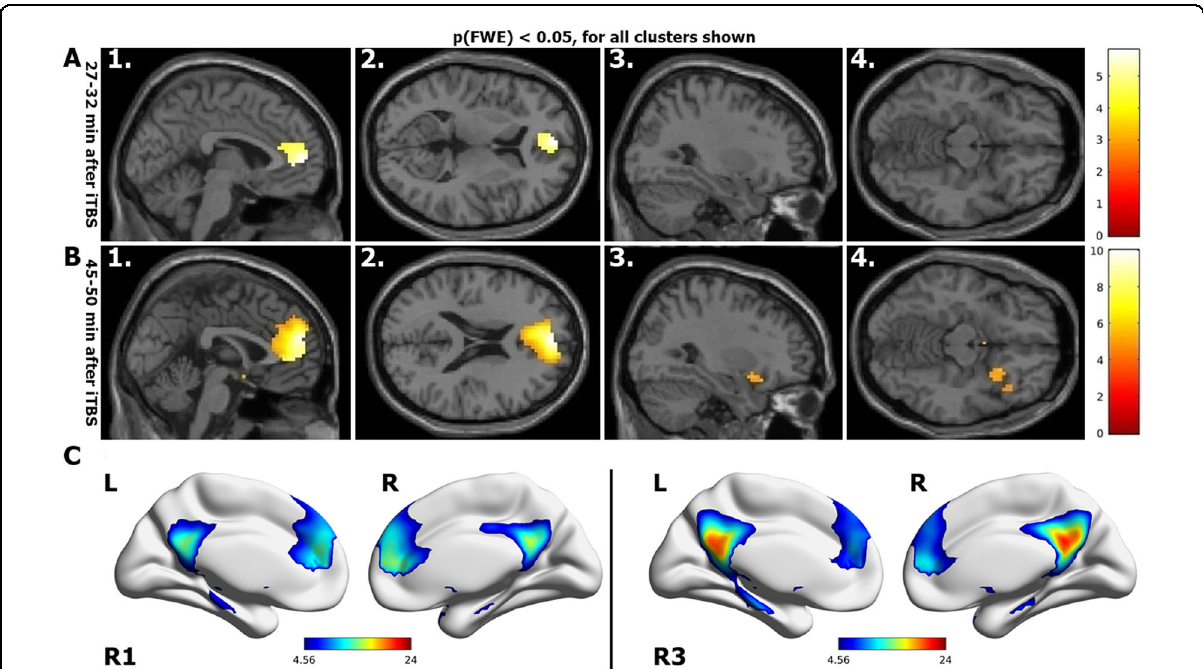
Fig. 3 Functional connectivity results. Regions that show reduced functional connectivity to DMN after stimulation (real-sham condition, whole- brain corrected p FWE < 0.05): ( a 1-2) About 27 min after iTBS, the rACC and dACC disengage from the DMN. ( b 1-2) About 45 min after stimulation, the functional connectivity has further reduced, extending to the mPFC and ( b 3-4) the right AI. c DMN during R1 rsfMRI and R3 rsfMRI session after real